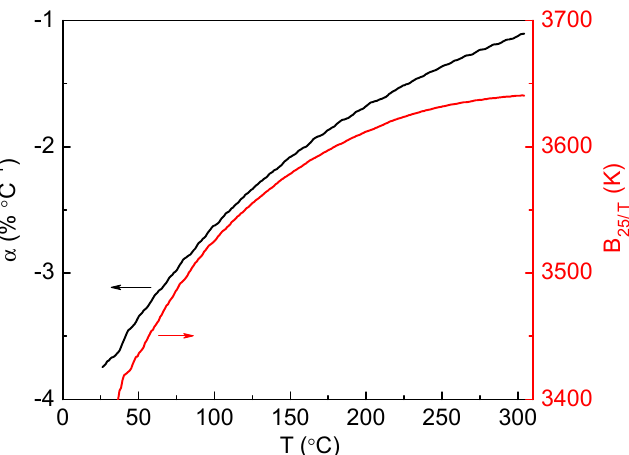
Figure 8. Temperature coefficient of resistance α and B 25 value (black/red lines referred to the left/right axes, respectively) as functions of temperature for the amorphous NNO film.